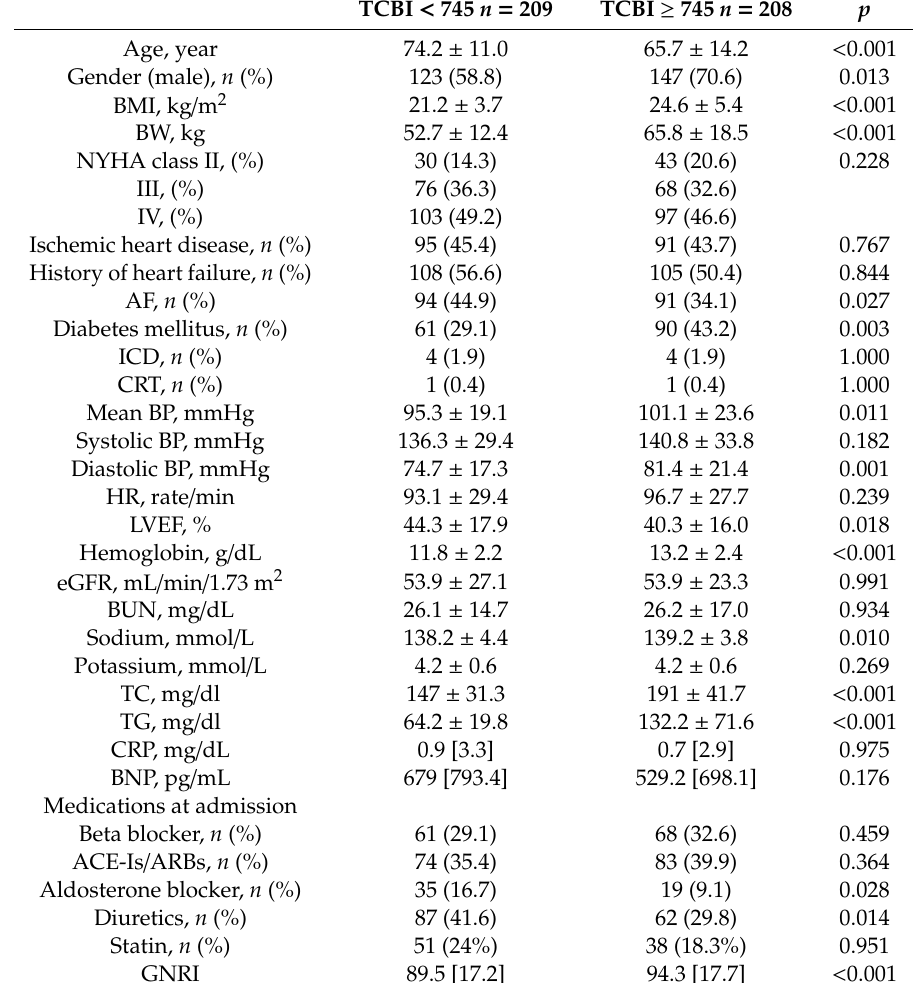
Table 1. Baseline characteristics of all